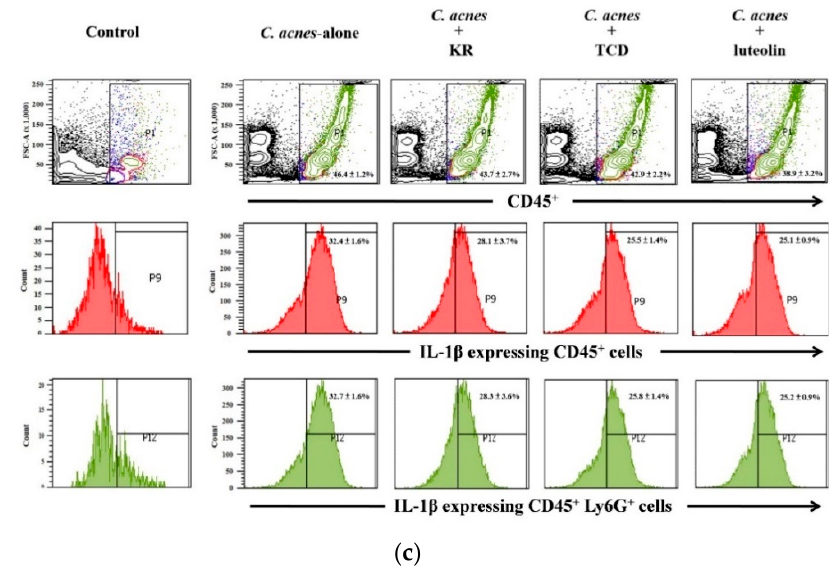
Figure 4. Effects of KR or TCD on C. acnes -induced mouse ear edema. PBS, KR (2.5 μ g/site), TCD (2.5 μ g/site), or luteolin (50 μ g/site) were intradermally injected, followed by immediate injection of C. acnes . Twelve hours after the injection, the inhibitory effects of KR or TCD on C. acnes -induced ear swelling were assessed by measuring the ear thickness ( a ), and C. acnes -induced inflammatory cells in mouse ear was performed by flow cytometry analysis ( b , c ). Each value represents the mean ± SD. Values with different symbols are considered to be significantly different from the C. acnes control ( C. acnes alone) at p < 0.05 (*), p < 0.01 (**) and p < 0.001 (***).